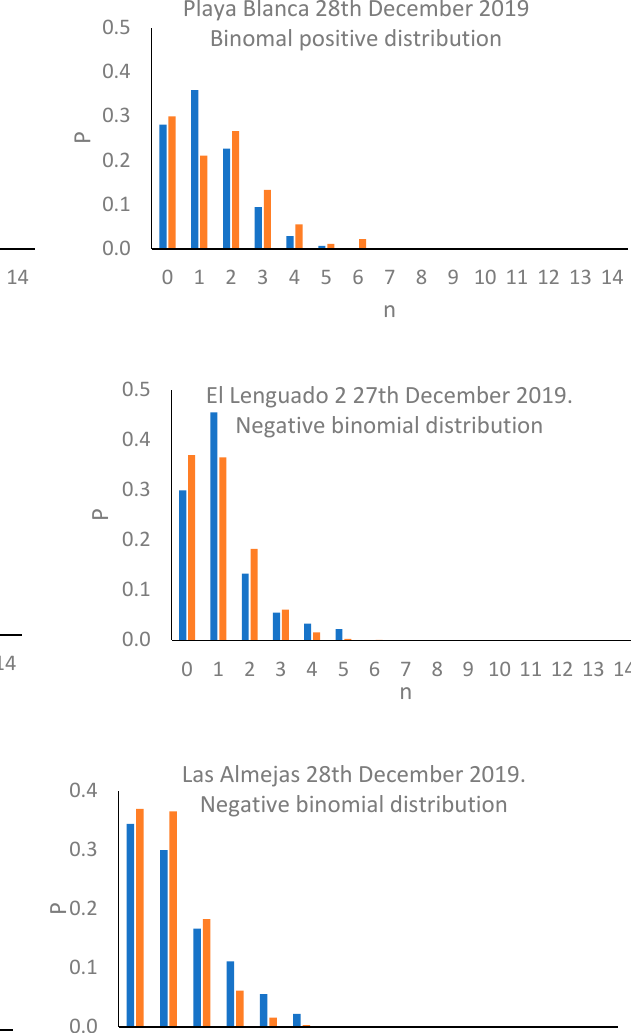
Negative binomial distribution.